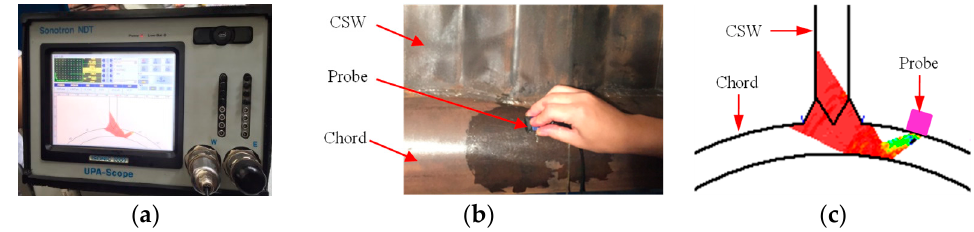
Figure 5. Phased array detection: ( a ) phased array; ( b ) detection photo; and ( c ) detection result.